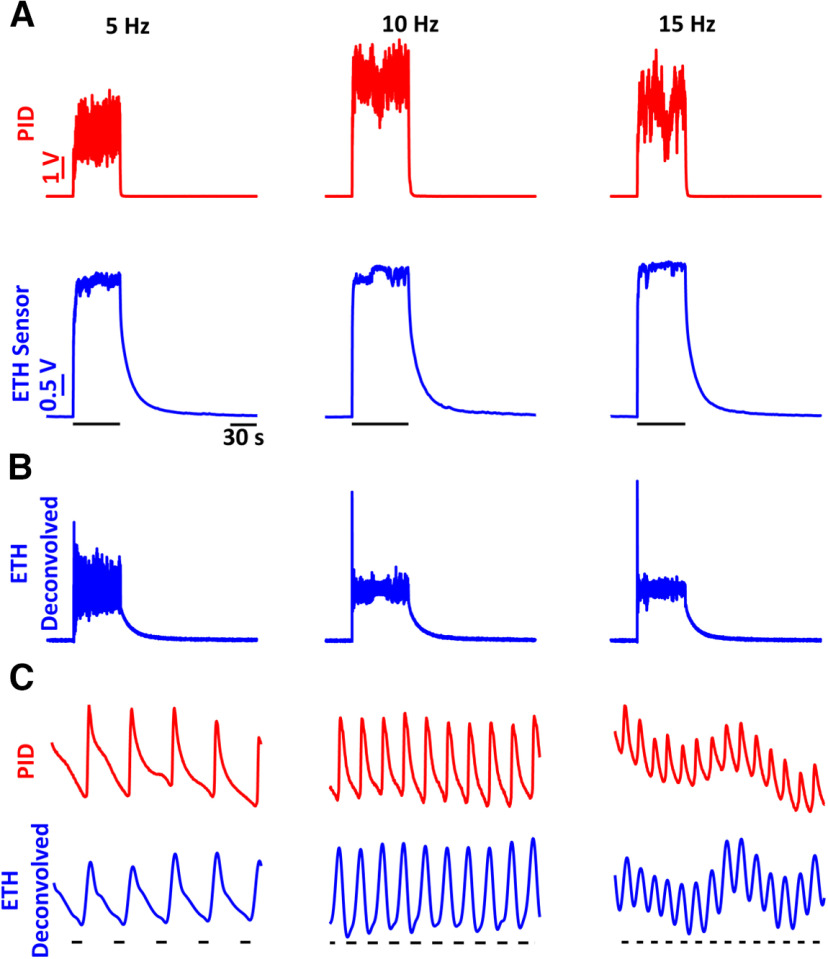
Frequency responses of the ethanol sensor show that the sensor can resolve frequencies of ethanol fluctuations up to 15 Hz. A, PID (red) and ethanol-sensor (blue) responses to single trials of ethanol fluctuations of 5 Hz (left), 10 Hz (center), and 15 Hz (right) frequencies. B, Deconvolved signals of the raw ethanol-sensor recordings presented in A. C, A 1-s zoomed-in view of the PID responses (red) and deconvolved ethanol signal (blue) showing near identical responses in the deconvolved signals and the PID recordings. The black bars underneath the traces indicate the times when the valve was open.